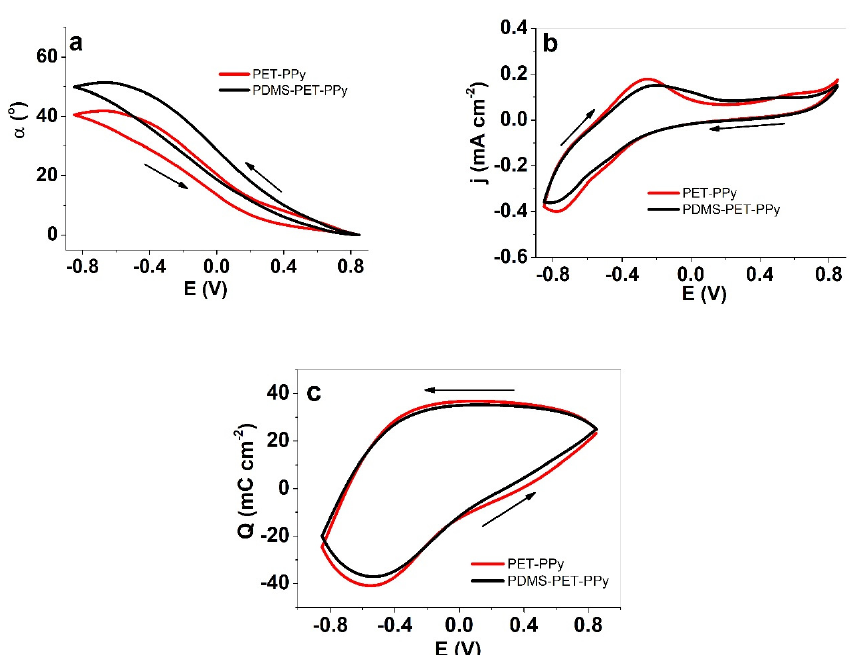
Figure 3. Cyclic voltammetry (10 mV s − 1 , third cycle) of PET-PPy (red) and (PDMS)PET-PPy (black) bilayers in aqueous 0.05 M TMACl showing ( a ) the angular displacement α , ( b )the current density j , and ( c ) the charge density Q against the potential E ( ± 0.85 V) against Ag / AgCl (3M KCl) reference electrode. The arrows indicate the start and ending of the cycle.